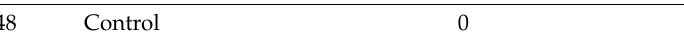
Table 1. Cont. No. Isolates Phytophthora Mycelium Growth Inhibition (%) 48 Control 0